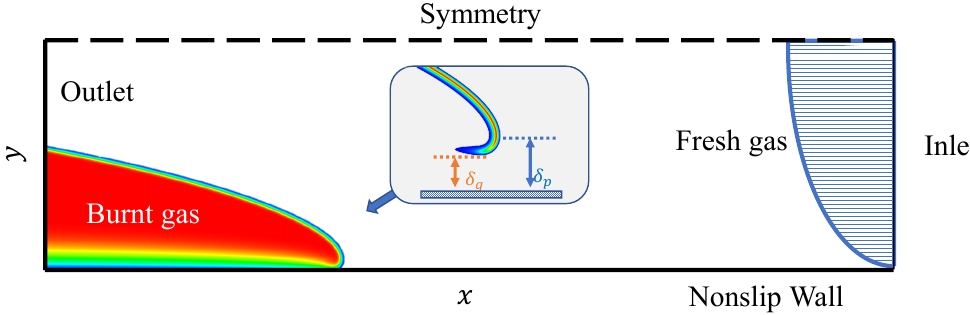
Figure 1. Sketch of the numerical setup, δ p is the penetration distance, and δ q is the quenching distance (see the